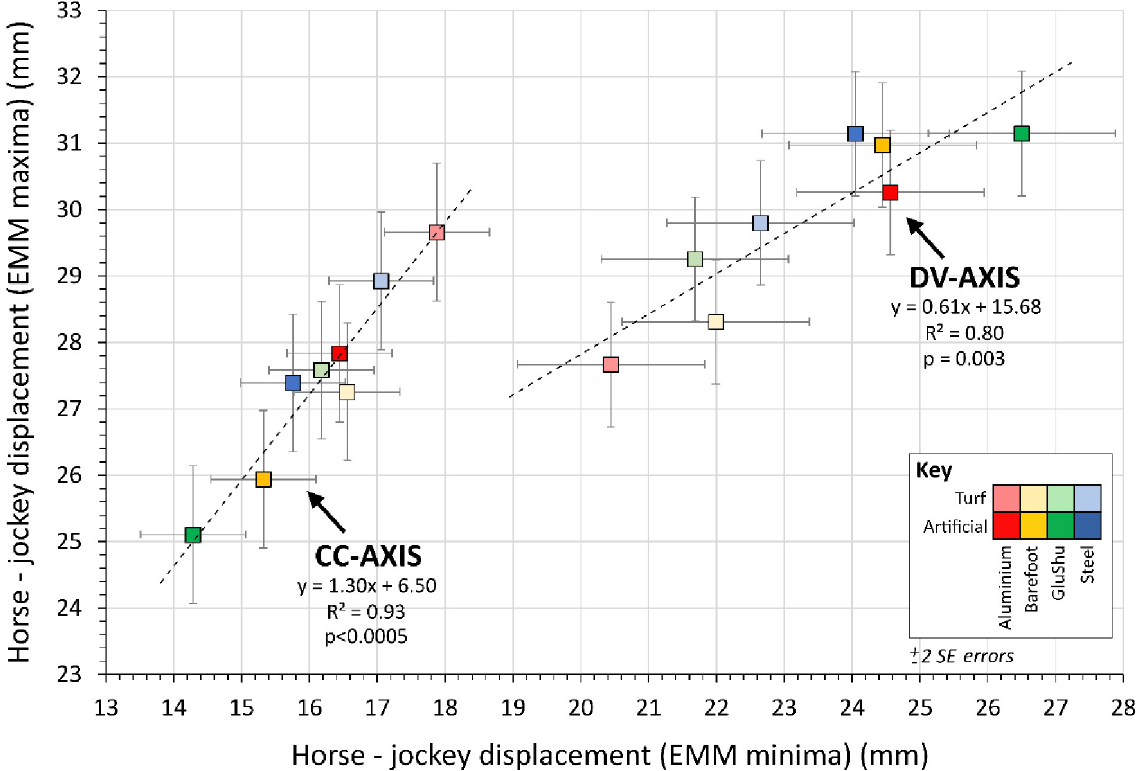
Fig 12. Relationship between minima and maxima of horse-jockey estimated marginal mean (EMM) differences per shoe-surface combination, sub-divided by displacement axis. Properties of the linear regression lines are indicated. Errors are ± 2 SE. Note: horse-jockey EMM differences in the medio-lateral axis were considerably smaller (Table 5), so are not